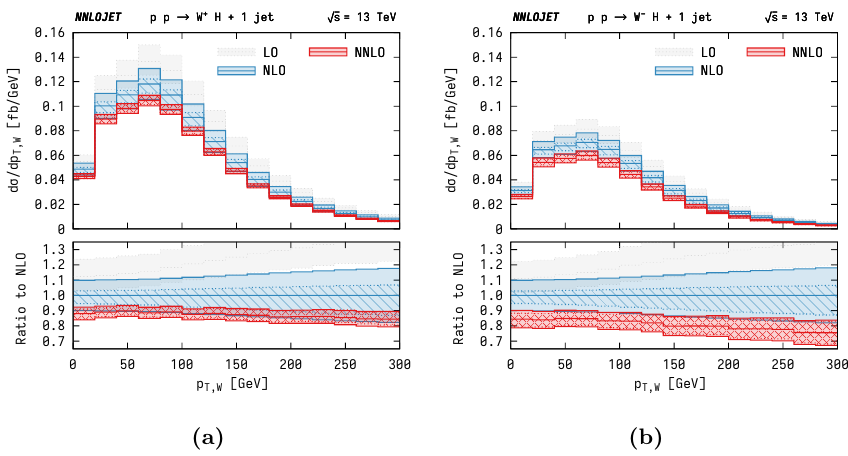
Figure 4. The transverse momentum distribution of the W boson produced in exclusive WH + jet production for (a) W + (b) W − .